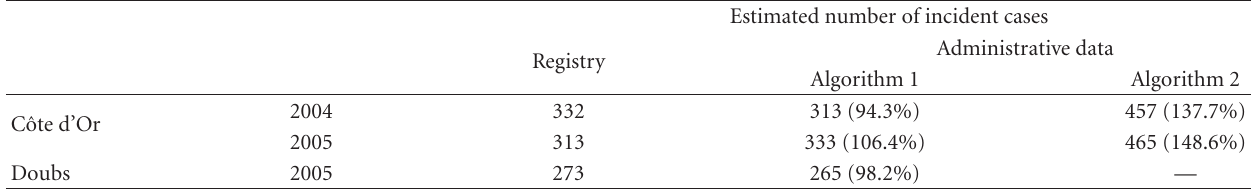
Table 1: Number of incident cases in Cˆote d’Or and Doubs estimated by Algorithms 1 and 2.